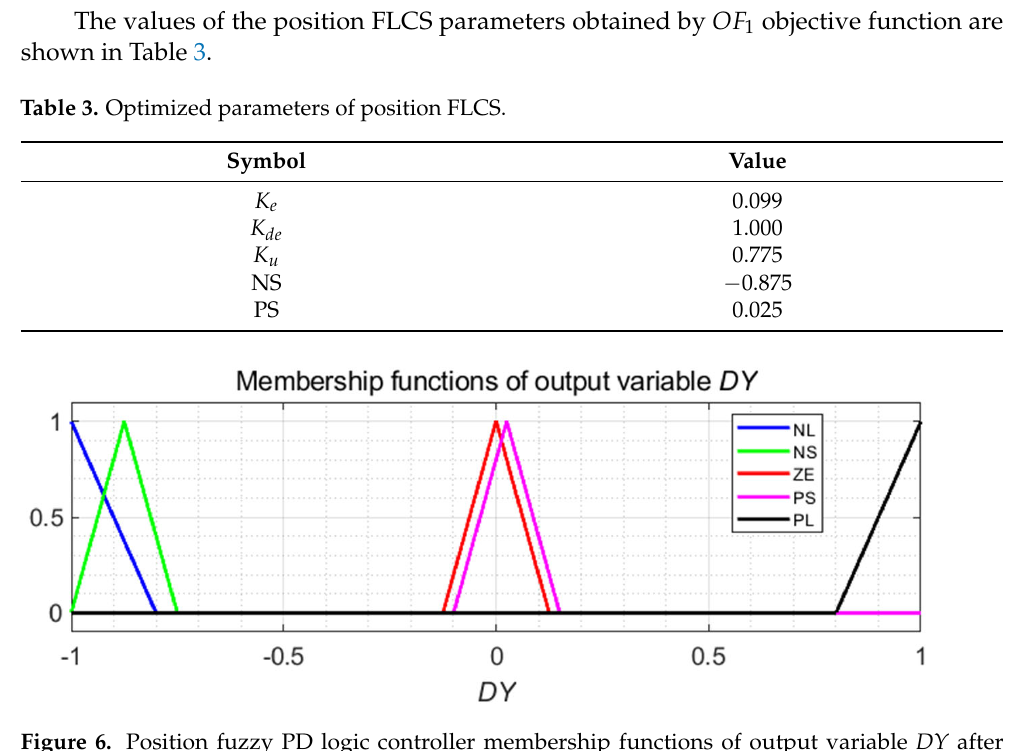
Figure 7. Control response obtained after the optimization process with the position FCLS. To improve the simple position FLSC, the fuzzy PD controller was set as a velocity controller in the inner control loop and the linear proportional controller in the outer con ‐ trol loop, as proposed in our previous work [18], where a linear velocity PID controller is used instead of a velocity fuzzy PD controller. Using the velocity error as the first input and the velocity error change over time as the second FLCS input leads to a velocity fuzzy PD control scheme, where the reference velocity signal is calculated by the linear P controller. In this case, the desired closed ‐ loop 0